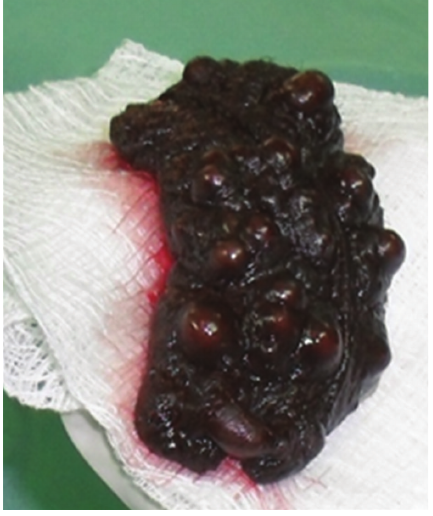
Figure 4: Postexcision scrotal calcinosis spacemen.